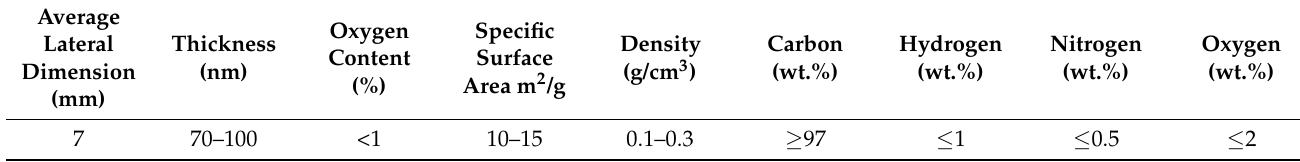
Table 1. Characteristics of graphene